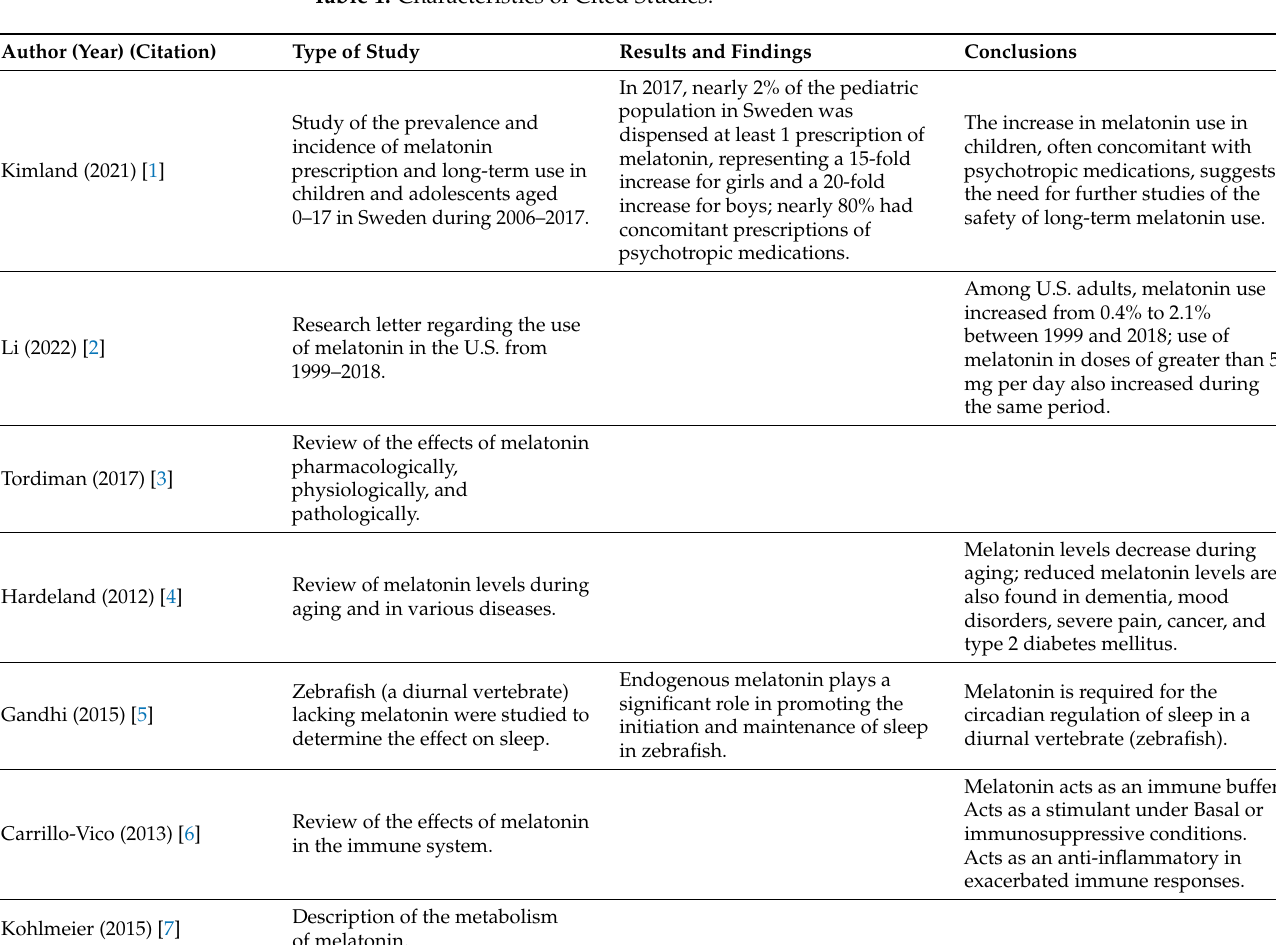
Table 1. Characteristics of Cited